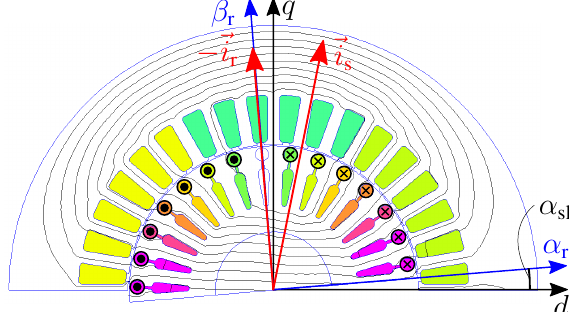
Figure 6. Example of 2D slice, used for the skewing analysis. The rotor and its electric load are rotated together, keeping the dq reference frame position